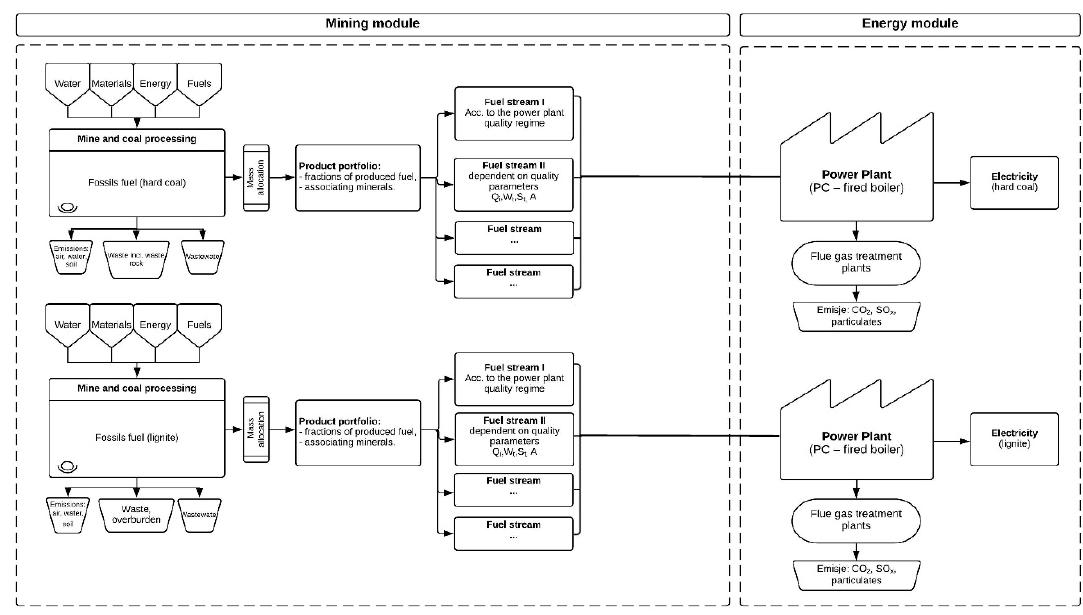
Figure 1. The structure of the model of the environmental impact assessment of electricity generation processes from selected carriers in Polish conditions (Q i —calorific value, W t —total water, A—ash content, S t —total sulphur content, PC—pulverised coal).